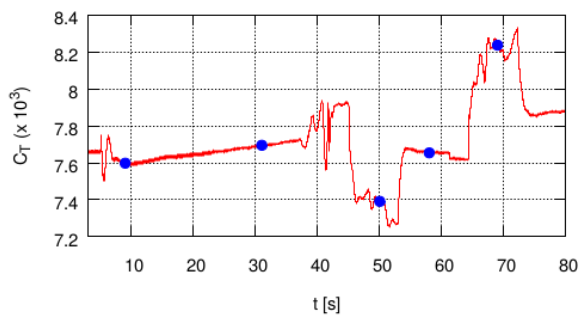
Figure 4: Thrust coeflcient time history in maneuver ID8021.